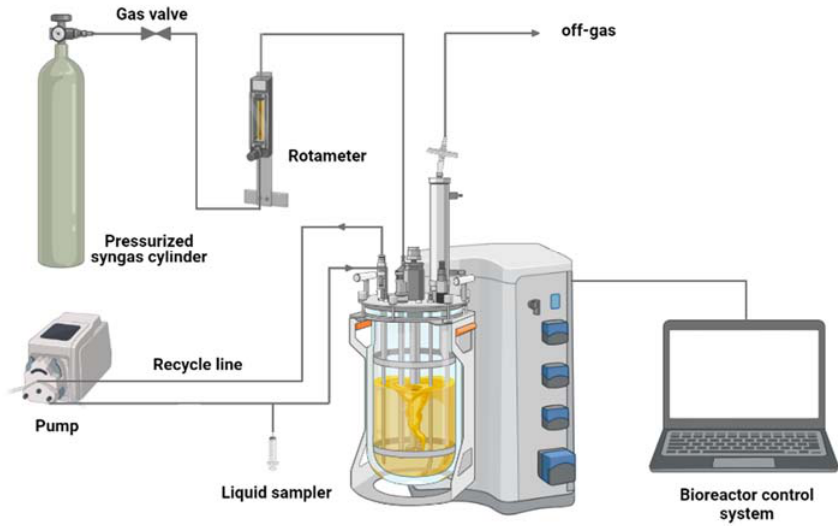
Figure 1. Schematic diagram of STBR used for C. carboxidivorans syngas fermentation. Created in Biorender.com (accessed on July 13, 2021).